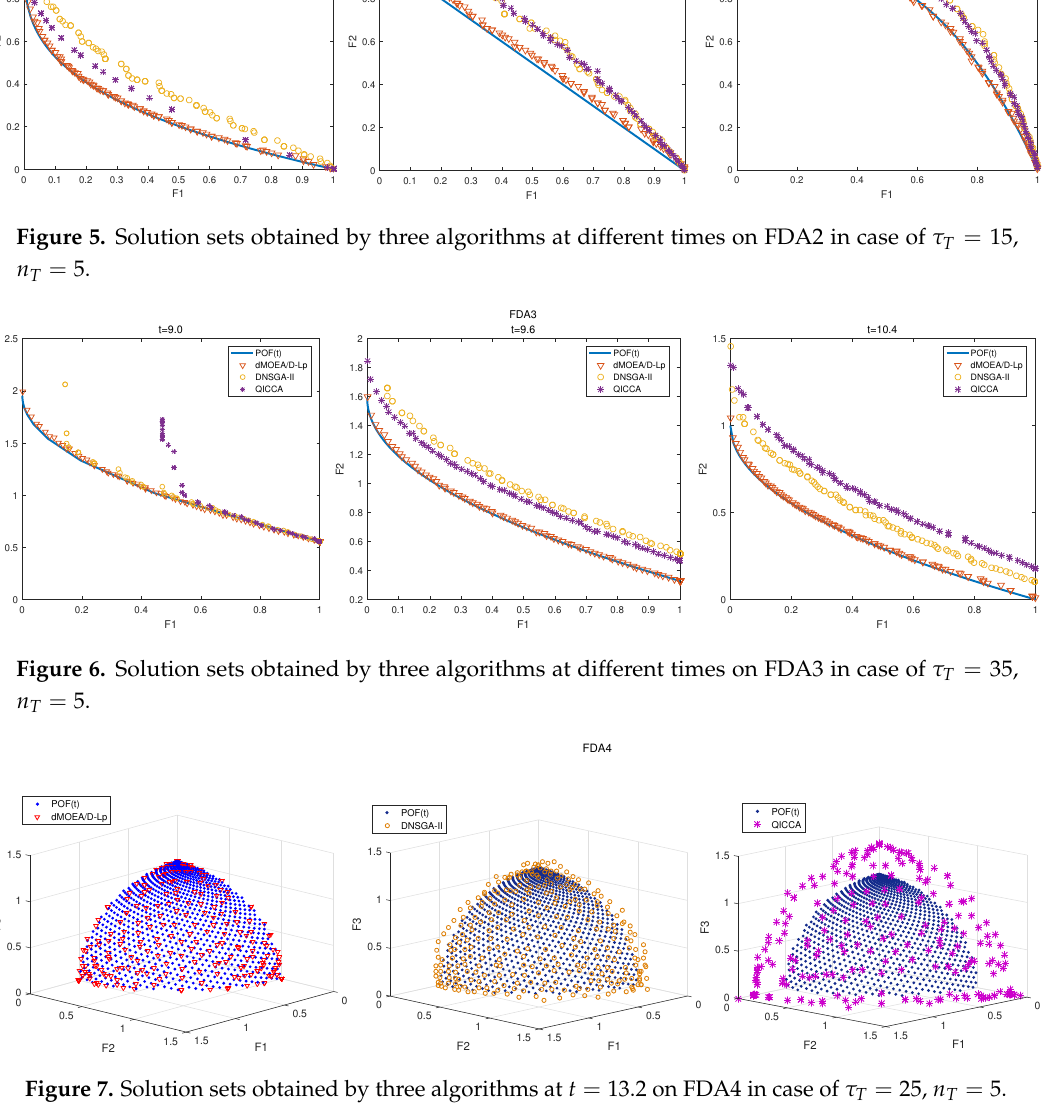
Figure 7. Solution sets obtained by three algorithms at t = 13.2 on FDA4 in case of τ T = 25, n T =